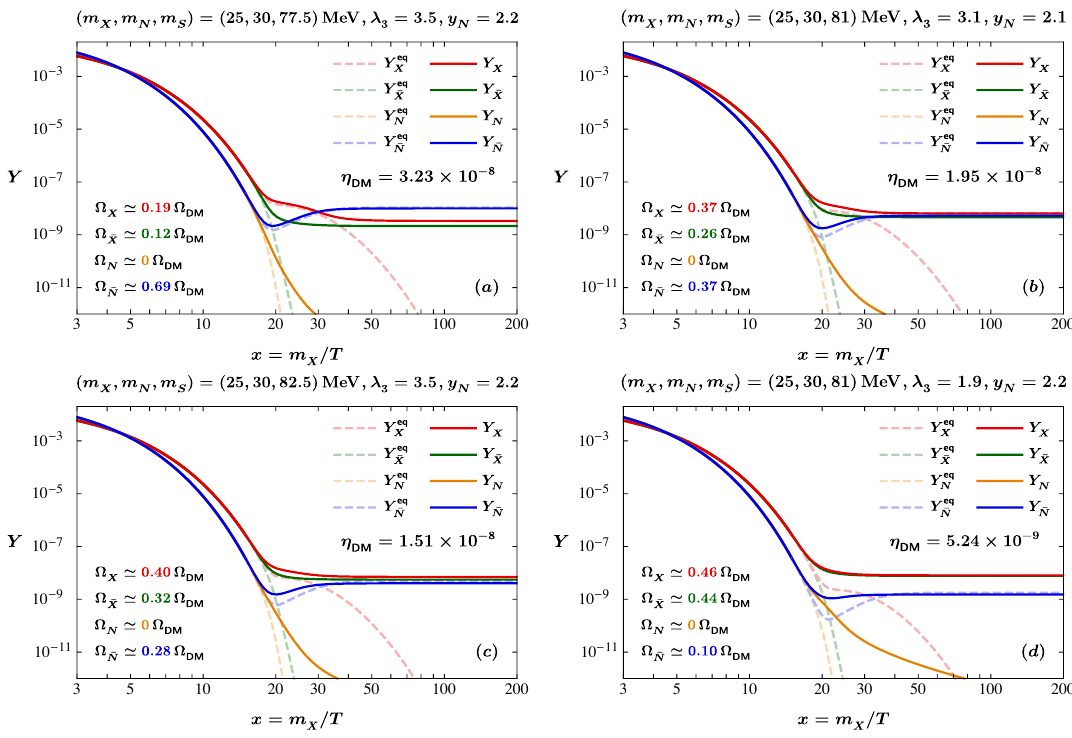
Figure 5 . Cosmological evolution of the comoving number densities of DM for r a SIMP model, where the color solid (dashed) curves are actual (equilibrium) number densities of DM, and we have fixed the (cid:15) = 10 − 3 , m